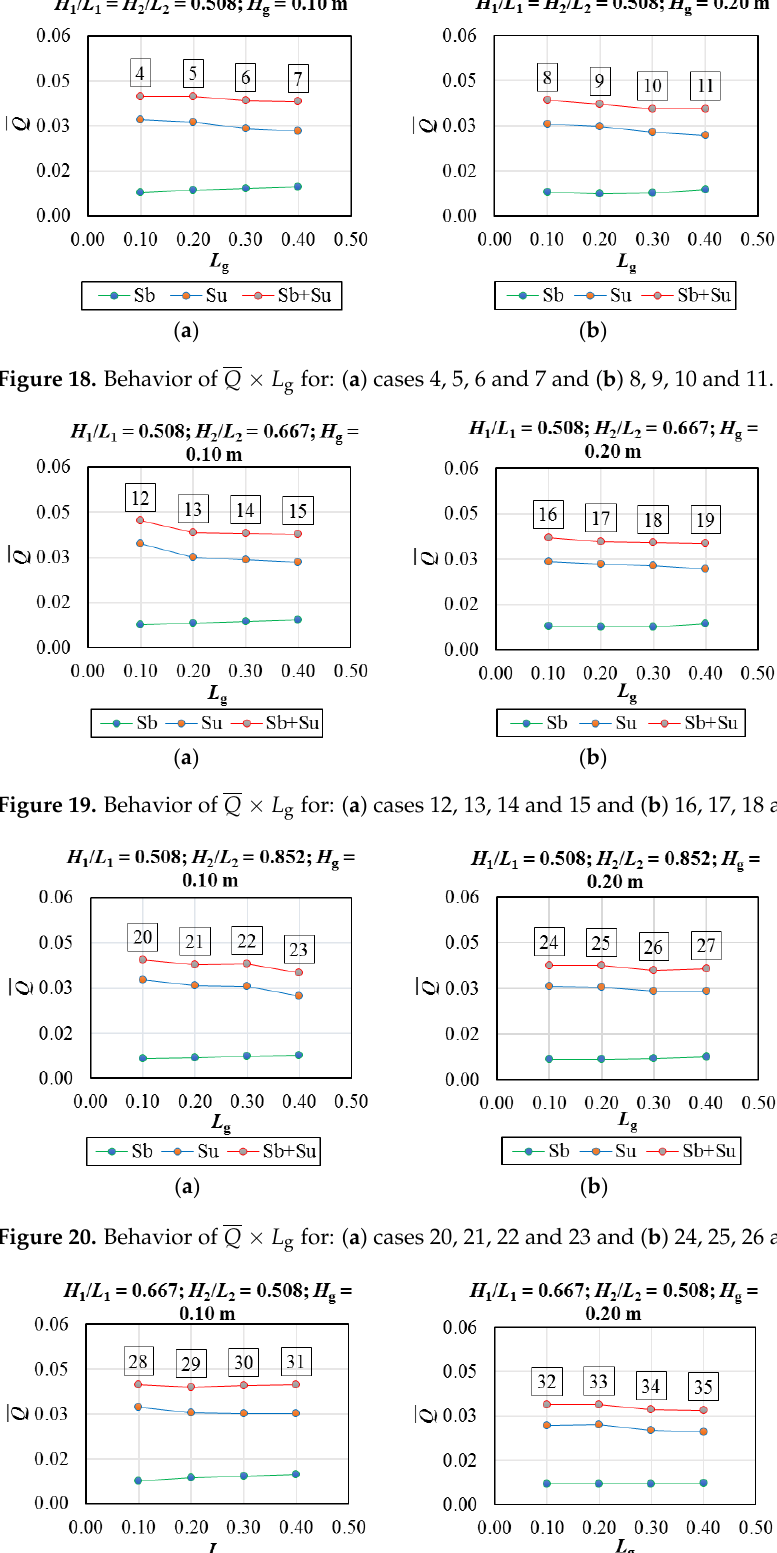
( b ) Figure 22. Behavior of Q ̅ × L g for: ( a ) cases 36, 37, 38 and 39 and ( b ) 40, 41, 42 and 43. ( a ) ( b ) Figure 23. Behavior of Q ̅ × L g for: ( a ) cases 44, 45, 46 and 47 and ( b ) 48, 49, 50 and 51. The gauge Sb for the block of Figures 24 – 26 showed similar behavior to the previous blocks. However, from Figures 24a – 26a the gauge Su achieved close values for Q ̅ when L g = 0.10 m for the three slopes of the upper ramp; but for the other L g distances, the in- crease of the H 2 / L 2 ratio led to the reduction of Q ̅ values. Moreover, for the block of Fig- ures 24b – 26b the gauge Su led to increased Q ̅ values with an increasing H 2 / L 2 ratio. Figure 27 shows the maximum magnitude graphs found among all proposed ramp configurations over the incidence of the sea conditions at the site of interest. Analyzing Figure 27, similar behavior and magnitudes of ( Q ̅ ) mm values can be observed as a function of H 1 / L 1 and H 2 / L 2 for the gauge Sb. However, case 38 (Figure 27b) presented a higher